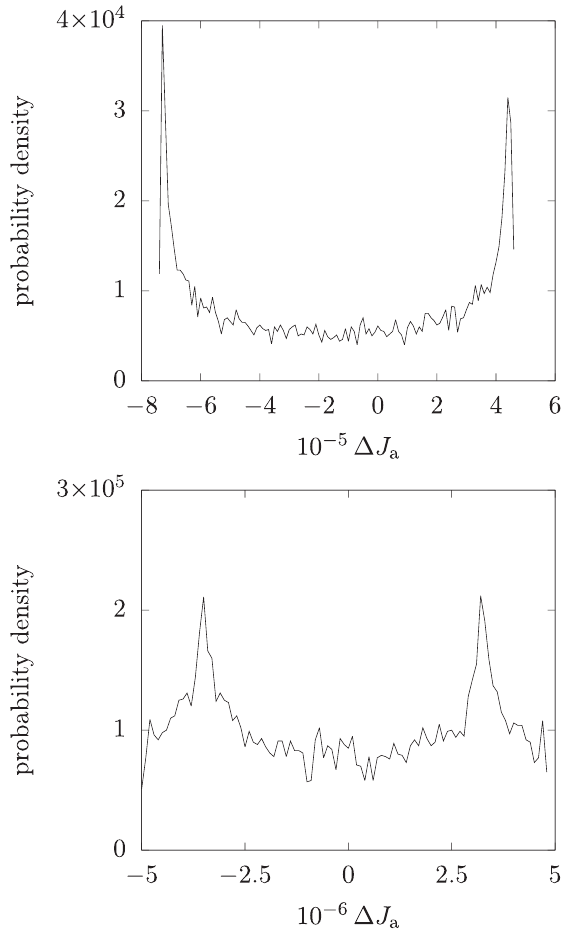
FIG. 8. Distribution of the jump of the invariant (difference between J and the expected one J a ; f 5 × 10 − 5 . Top: N ¼ 10 4 , i.e. ϵ ¼ 2 × 10 − 5 , Bottom: J 1 ; i ¼ N ¼ 5 × 10 4 , i.e. ϵ ¼ 4 × 10 − 6 . The map (60) has been used, with parameters q ¼ − 0 . 005 , ω 2 × 10 − 4 . J b ¼